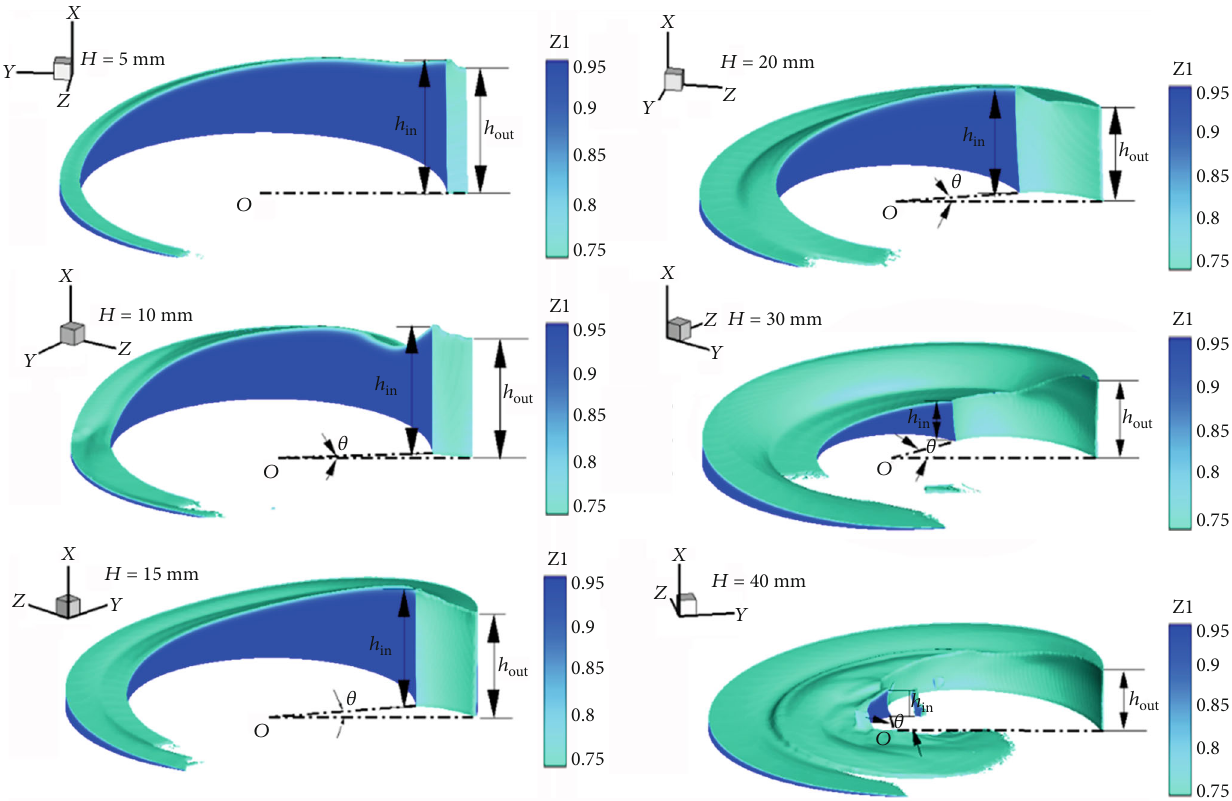
Figure 12: 3D distribution of the detonation